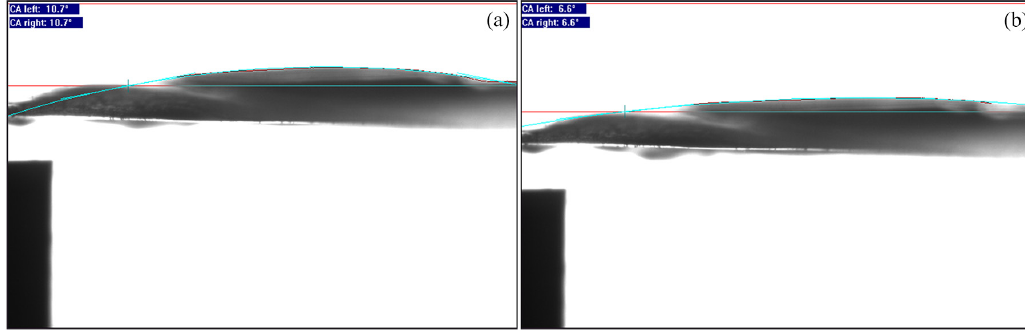
Figure 3. Analysis of contact angle for sample: (a) zero time and (b) 5